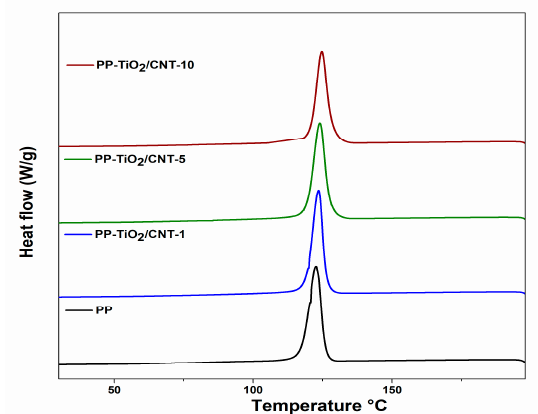
Figure 5. Differential scanning calorimetry (DSC) crystallization exotherms of pure polypropylene (PP) and PP-TiO 2 /CNT (carbon nanotubes) (1, 5, 10%).